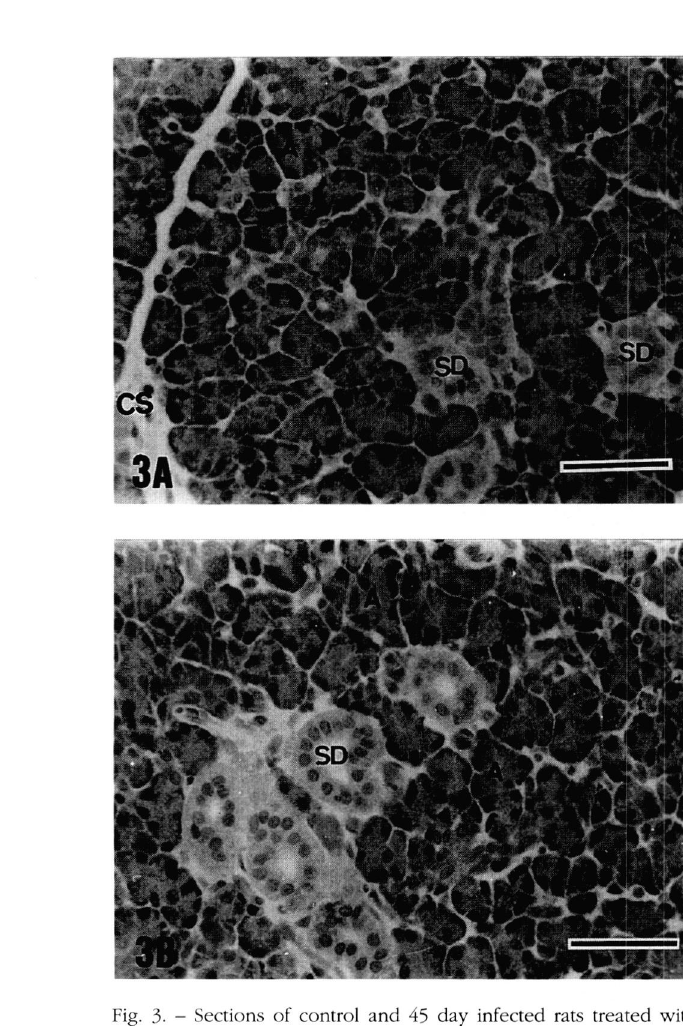
Fig. 3- - Sections of control and 45 day infected rats treated with colchicine. (a) Control, (b) Infected-rats. Control and infected animals exhibit the same feature histologic. Dominicci. Bar: 50 Um.